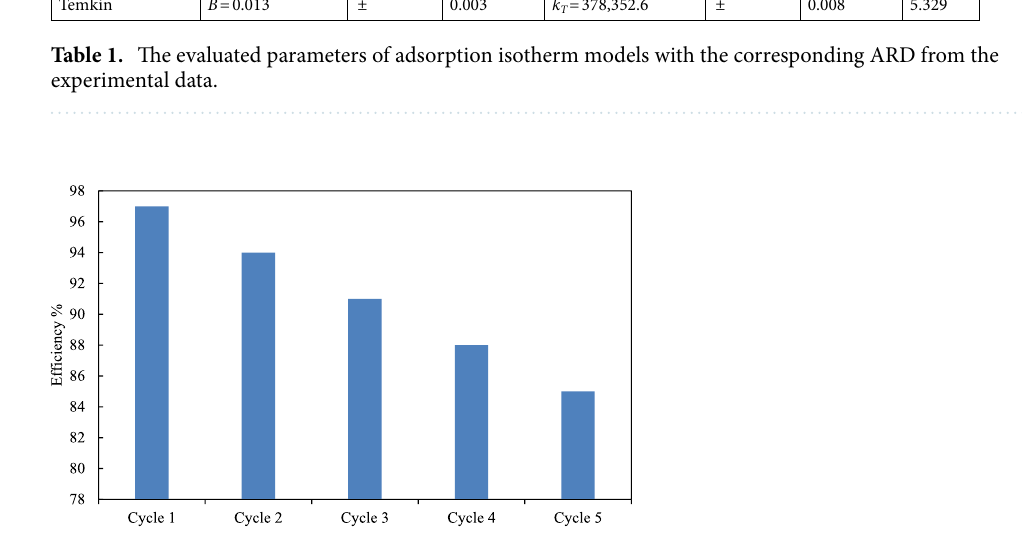
Figure 13. The efficiency of the TiO2@PVA nanocomposite in the optimized Congo red dye removal process after recovering in different cycles of